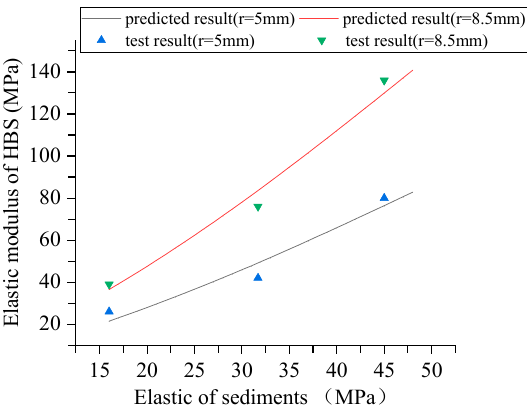
Figure 13. Comparison between test and theoretical results for elastic moduli.